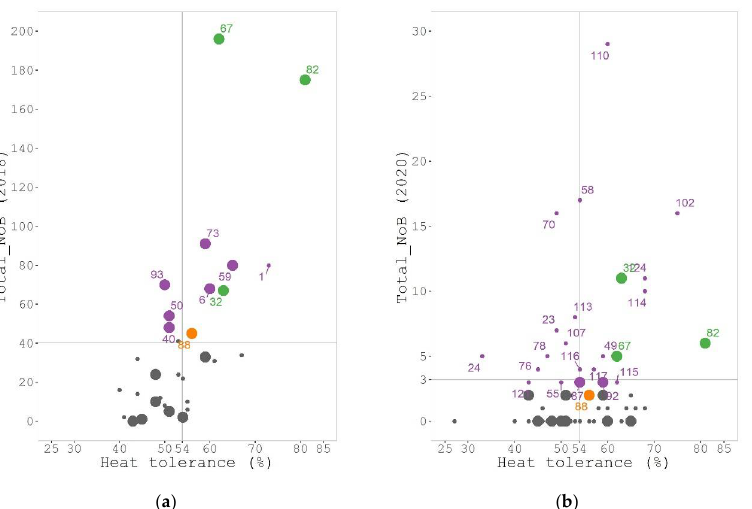
Figure 7. Scatter plot showing the Total_NoB (total number of beans) and estimated heat tolerance of ( a ) 33 genotypes phenotyped in 2018, and ( b ) 64 genotypes phenotyped in 2020. Average estimated heat tolerance and Total_NoB are indicated. All genotypes that developed more beans than Bonela are labeled. Genotypes that were phenotyped in both years are enlarged. Reference variety Bonela (88) is colored in orange, genotypes with a higher Total_NoB either in 2018 or 2020 are colored in purple, and genotypes 32, 67 and 82 that developed more beans than Bonela in both years are marked in green.